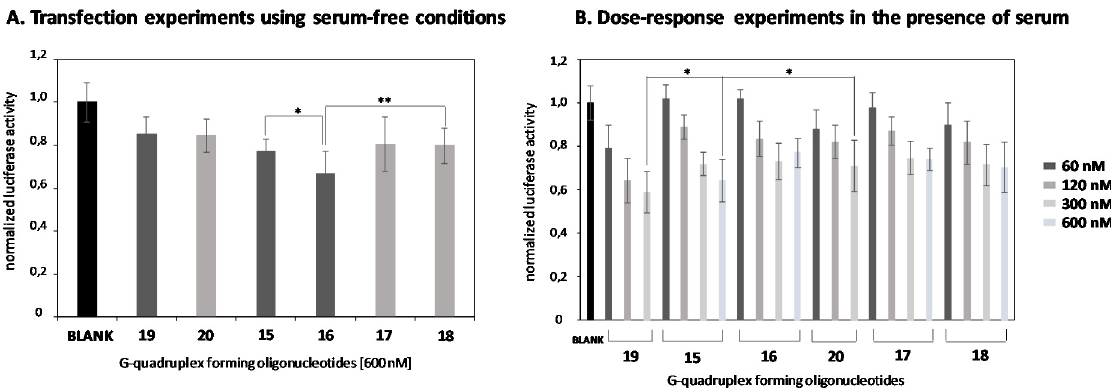
Figure 8. Gene transfection studies targeting Renilla luciferase mRNA without using lipofectamine in serum-free conditions ( A ). Modified and unmodified antisense conjugates ( 15–18 ) and ( 19 , 20 ) were used at 600 nM. ( B ) Dose-response transfection experiments using several concentrations (60, 120, 300 and 600 nM) in the absence of lipofectamine. G4_( 19 , 20 ) were used as controls. Data were means ± SD of three to six independent experiments. A regular two-way ANOVA variance analysis, combined with Bonferroni post-test for multiple comparisons, was evaluated (* p < 0.05 and ** p < 0.01).